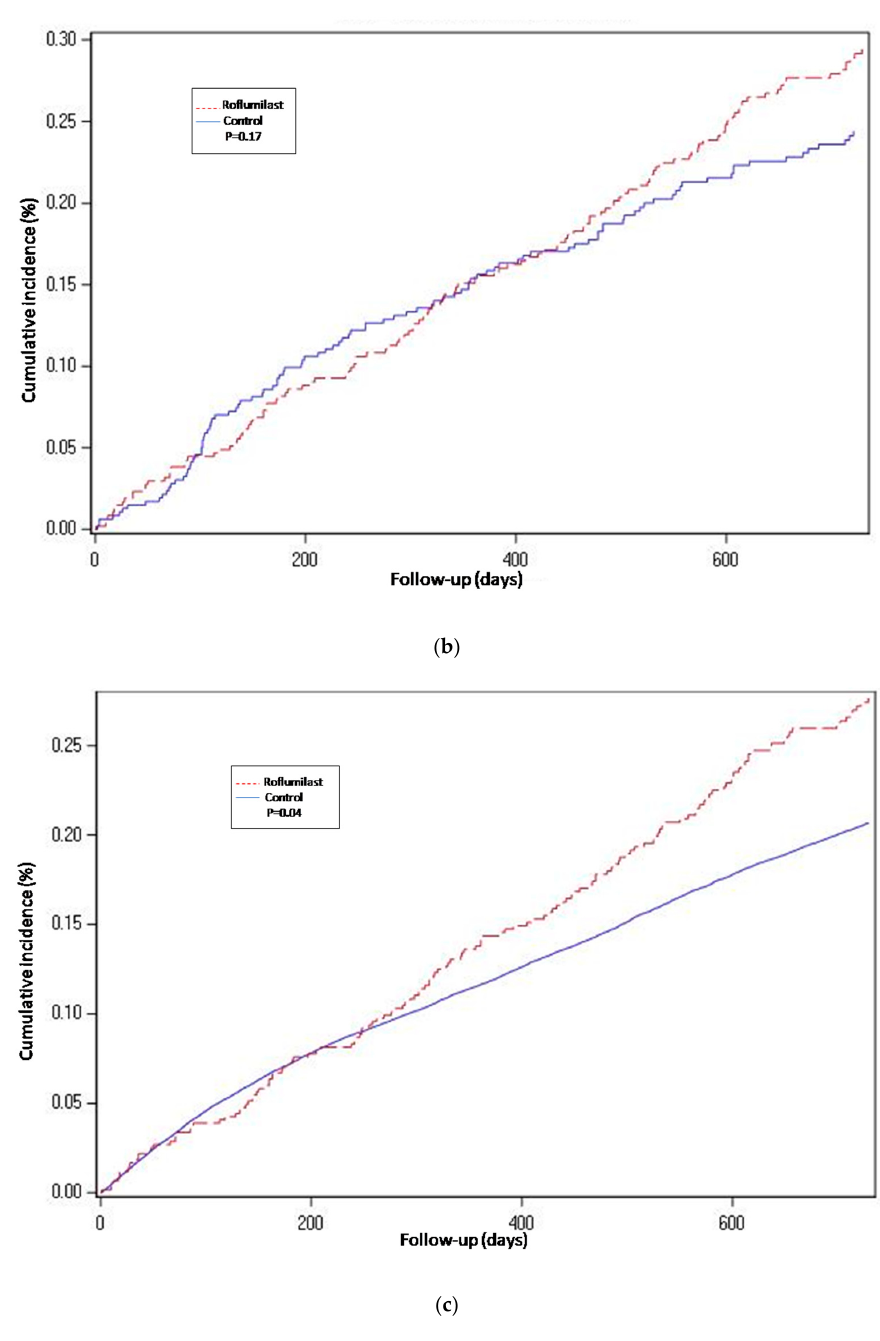
Figure 4. Cumulative incidence curves for all-cause mortality. ( a ) Propensity-matched population (Roflumilast vs. Control). ( b ) Roflumilast versus Theophylline. ( c ) Unmatched population (Roflumilast vs. Control).